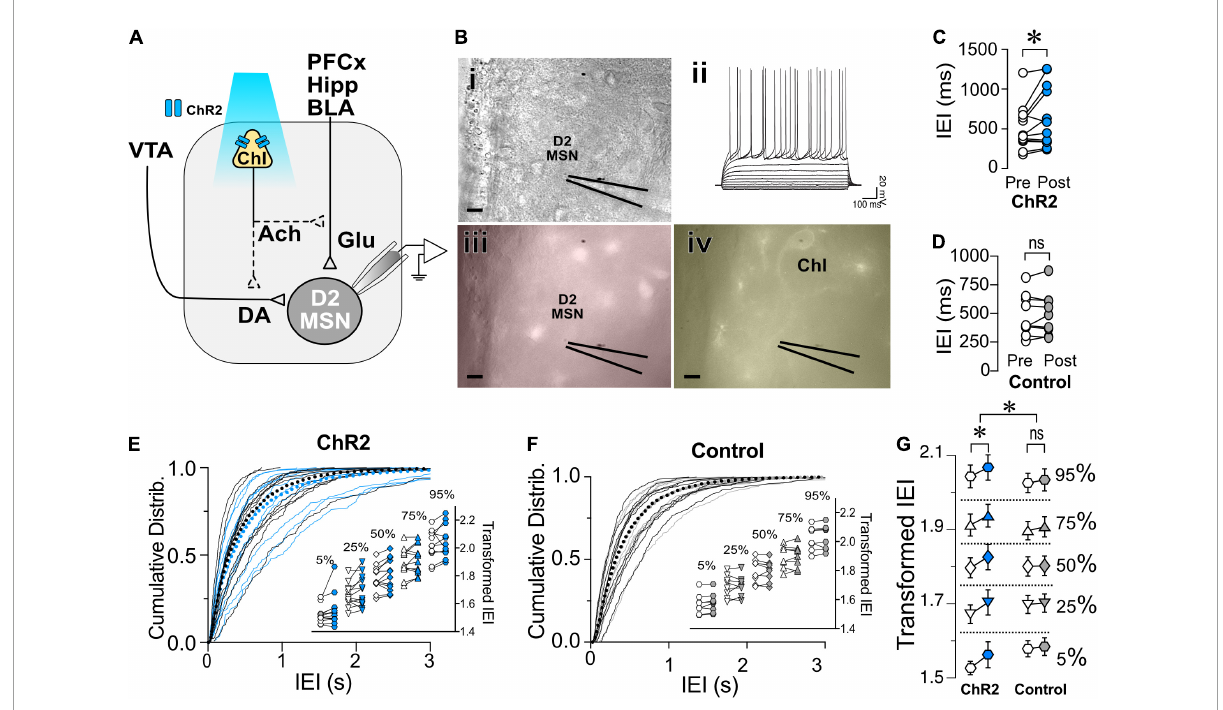
FIGURE3 Optogenetic stimulation of ChIs decreases sEPSCs frequency in D2-MSNs. (A) Schematic of the experimental setup: whole cell sEPSC recording of D2-MSNs during optogenetic stimulation of ChIs. (B) Same slice images of representative MSNs [ (i) , DIC], corresponding IV traces to confirm MSN identity (ii) , lack of red-epifluorescence to verify the cell is D1R (–) (iii) , and eYFP epifluorescence of ChI cell in the proximity of the recording (iv). Scale bar 10 um. (C) Average sEPSCs IEI before (Pre, white circles) and after (Post, blue circles) optogenetic stimulation of ChIs in ChAT-ChR2 D2-MSNs ( n = 12). (D) Average sEPSCs IEI before (Pre, white circles) and after (Post, gray circles) optogenetic stimulation of ChIs in tdTomato control mice ( n = 9). (E) Cumulative frequency distribution of D2-MSN IEI of sEPSCs in ChAT-ChR2 mice before (Pre, black traces) and after (Post, blue traces) ChI optogenetic stimulation. Each solid line represents a neuron. Average traces are shown in dotted black and blues lines for Pre and Post conditions, respectively. Inset. Cumulative distributions of ChAT-ChR2 D2-MSNs EPSCs IEIs broken into percentiles of distribution to quantify median (50%), shoulders (25 and 75%), and extreme values (5 and 94%) of distribution, that are 1 10 transformed to normalize the distribution. (F) Cumulative frequency distribution of D2-MSN IEI of sEPSCs in tdTomato mice before (Pre, black traces) and after (Post, blue traces) ChI optogenetic stimulation. Each solid line represents a neuron. Average traces are shown in dotted black and blues lines for Pre and Post conditions, respectively. Inset. Same as inset in panel (E) , but in TdTomato D2-MSN controls. (G) Percentiles of cumulative distribution of transformed IEIs of EPSCs in ChAT-ChR2 D2-MSNs (Pre, white circles, Post, blue circles) and control TdTomato D2-MSNs (Pre, white circles, Post, gray circles). * p < 0.05, ns, no significant